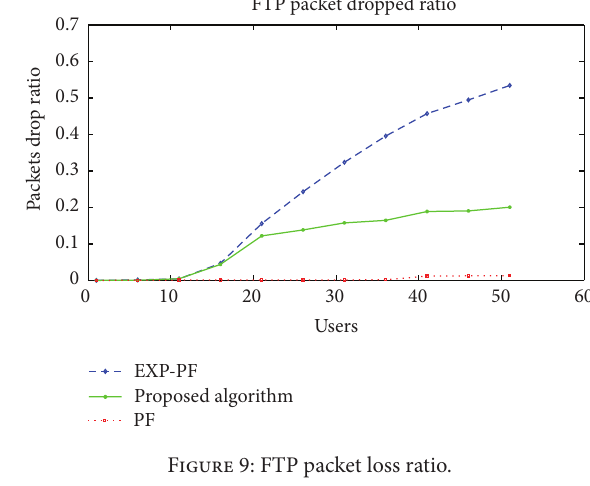
Figure 7: FTP traffic sent.